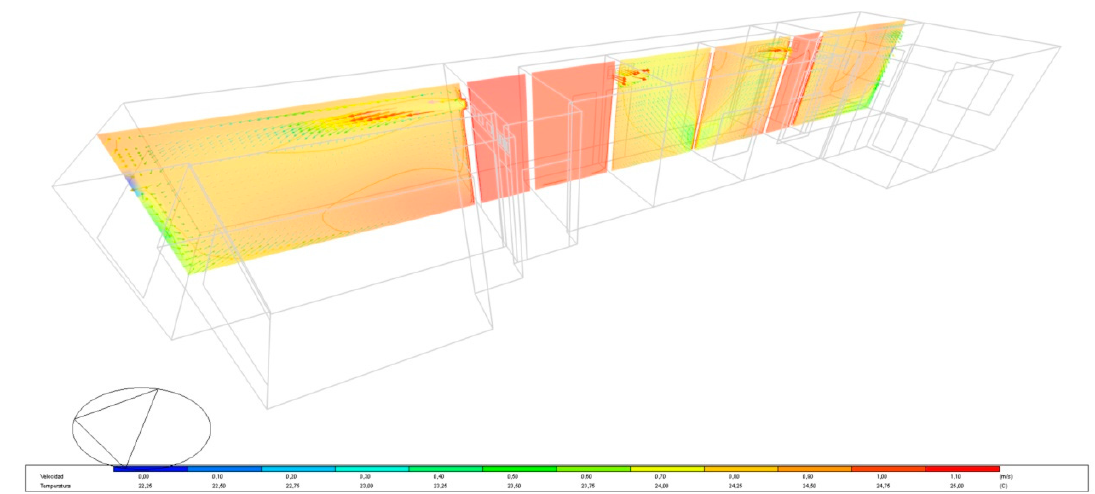
Figure 22. The all-air system with air conditioning and an air drive (convective); 1 August 2015, 4:00 p.m.